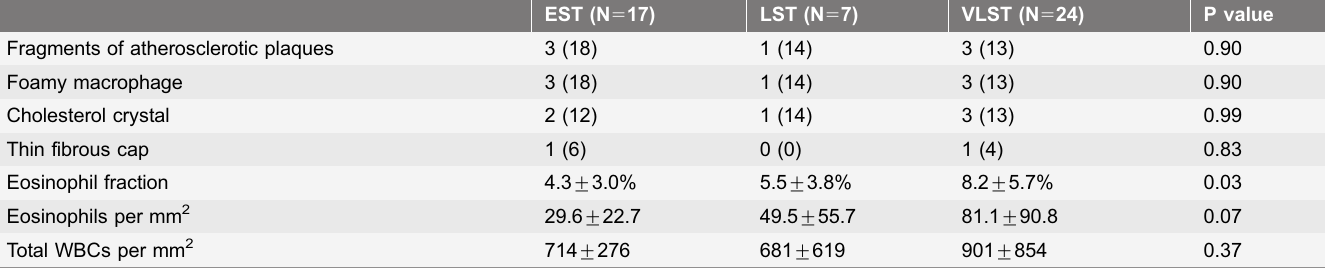
Table 4. Pathologic Findings in the Aspirated Thrombi According to the Timing of Stent Thrombosis.